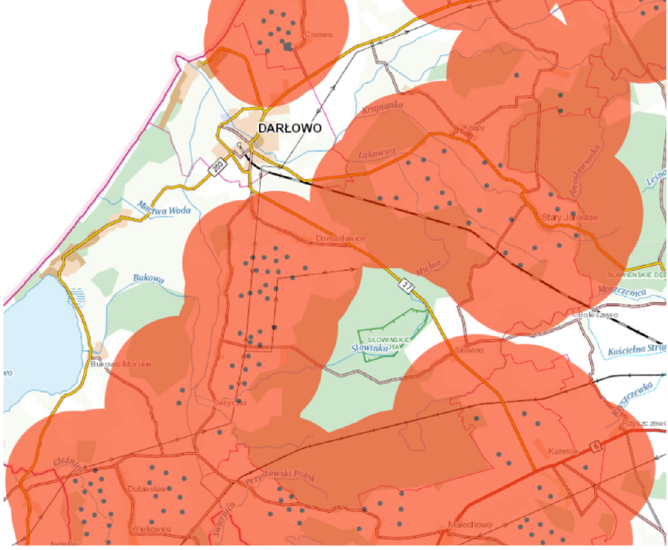
Figure 2. ‘Exclusion zones’ around wind turbines in the town and municipality of Dar ł owo in 2022 [59].